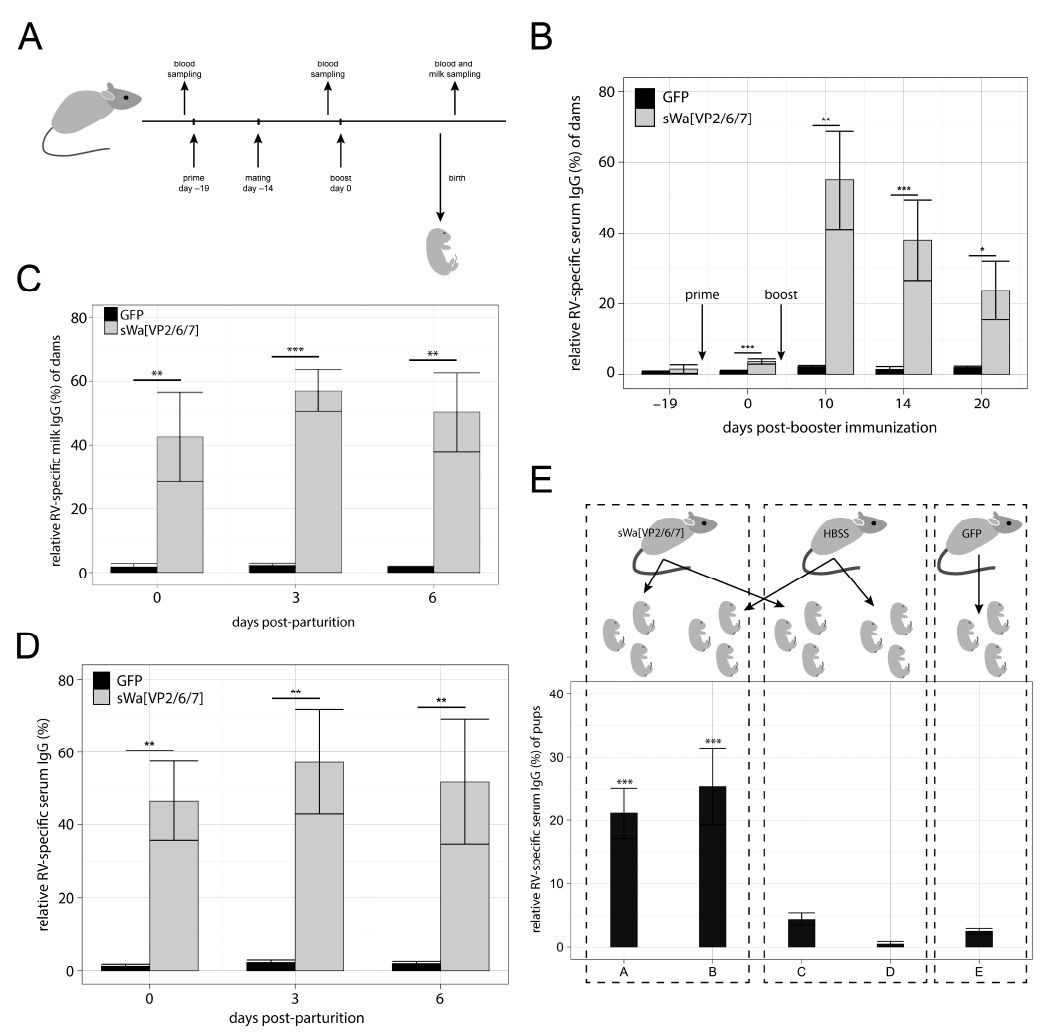
Figure 3. Immune response in mice upon immunization with the vaccine vector sWa[VP2/6/7]. ( A ) Schematically represented in vivo studies as timeline. Before the immunization of female BALB/c mice a blood sample was collected from each animal. Five days after intra muscular (i.m.) injection of the prime dose, a male was added for mating. Before booster immunization, blood samples were taken. For the first set of experiments, mice received a booster immunization at 19 days after prime dose injection, and, for the second set of experiments, at 20 days after prime dose injection. Blood and milk samples were taken on a regular basis starting on the day of parturition. ( B – D ) Rotavirus specific immunoglobulin G (IgG) serum ( B , D ) or milk ( C ) levels of immunized mouse dams determined by enzyme-linked immunosorbent assay (ELISA). Rotavirus-specific IgG in sera (1:5000 dilution) or milk (1:500 dilution) of either sWa[VP2/6/7] or GFP amplicon vector immunized animals was measured and plotted relative to the positive control applied on each ELISA plate that was taken as 100%. As positive control always the same sera of a RV hyperimmunized mouse from a previous study [17] (diluted 1:5000) was used. Relative IgG values were plotted on the ordinate in relation to the time after booster immunization in days on the abscissa. Values from naïve sera are plotted on the time point − 19 as these samples were taken before the first immunization ( B ). In ( B ), time point 0 indicates relative sera IgG levels before booster immunization, time point 10 includes values from animals from 9 to 10 days post-booster immunization (dpb), time point 14 includes samples taken on 13 and 14 dpb and